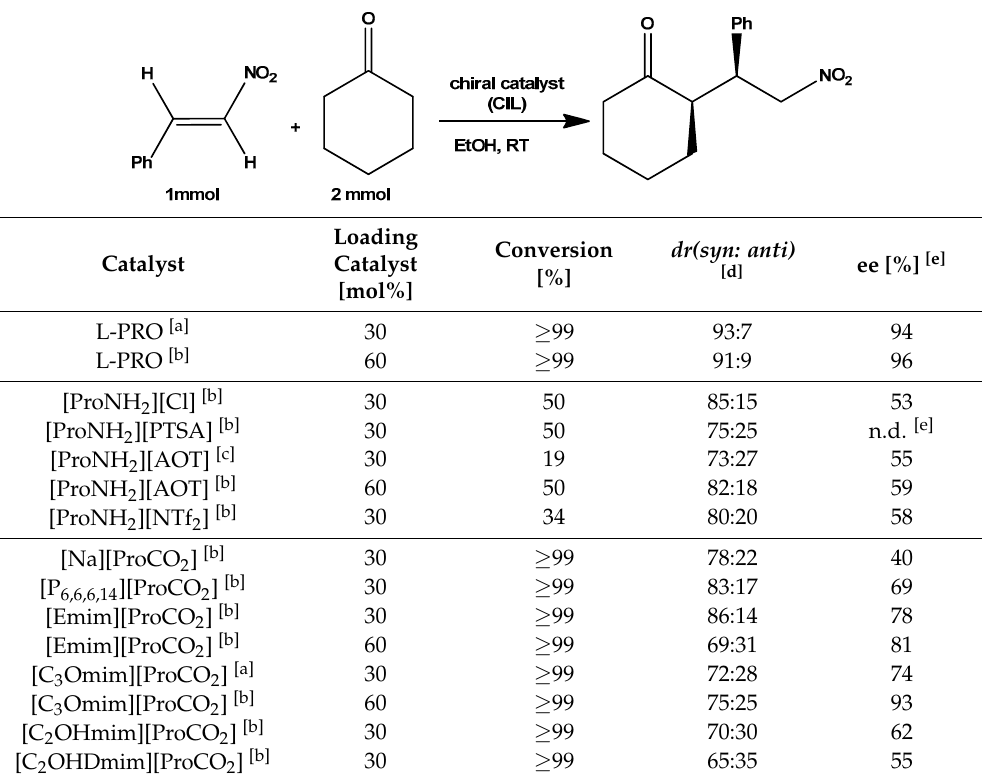
Table 2. Michael addition of cyclohexanone to trans-nitrostyrene catalyzed by CILs based on L-proline using EtOH as solvent.